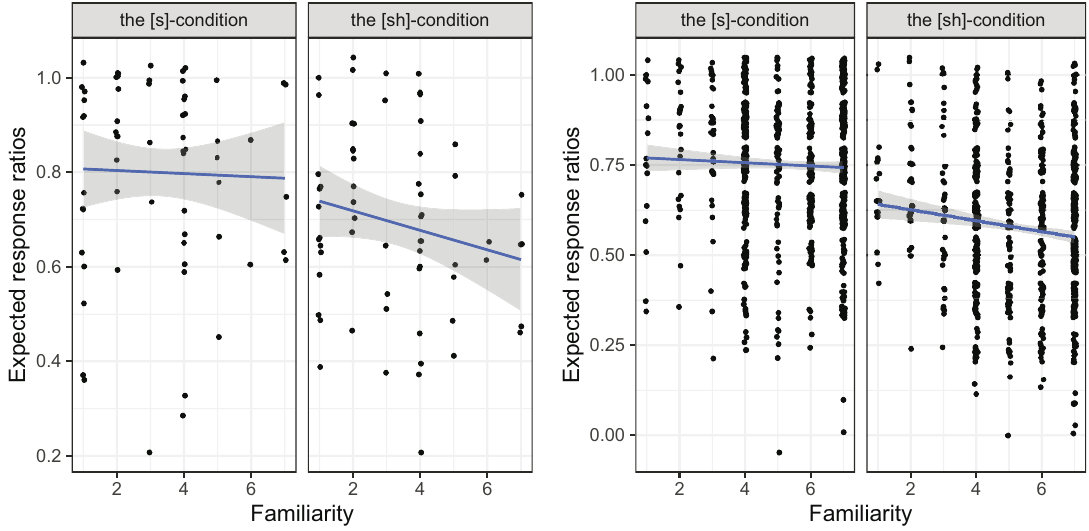
Figure 4: Correlation between familiarity with Pokémon and expected response ratios. Left = the small data set; right = the large data set. The solid lines are linear regression lines. The gray areas represent the 95% con fi dence